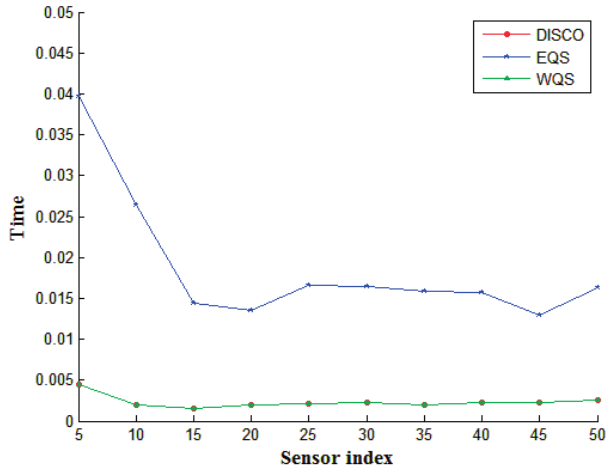
Figure 10. The computation time on different device